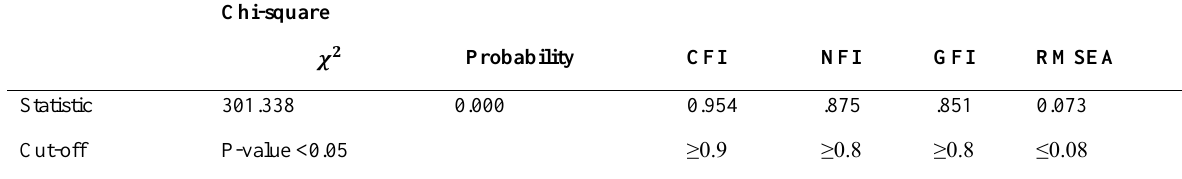
Table 3: The Influence of Corporate Reputation on Performance of hotels